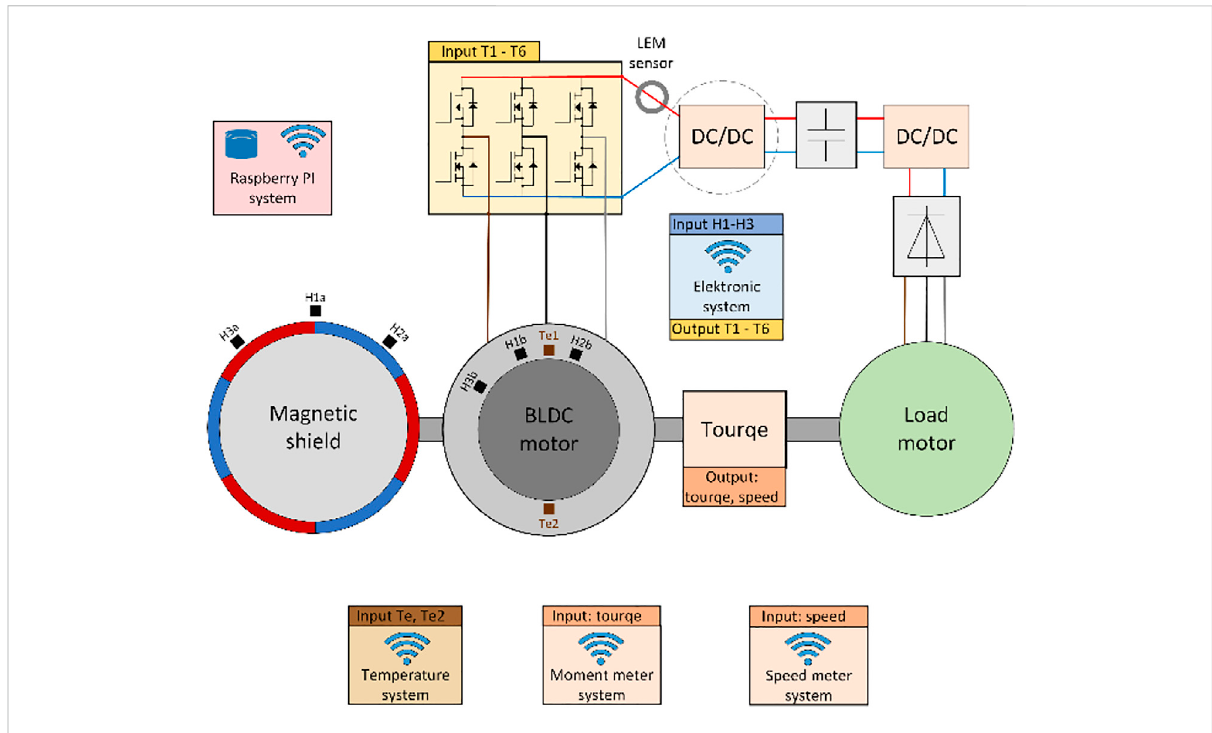
FIGURE 1 Scheme of the construction of the BLDC engine.